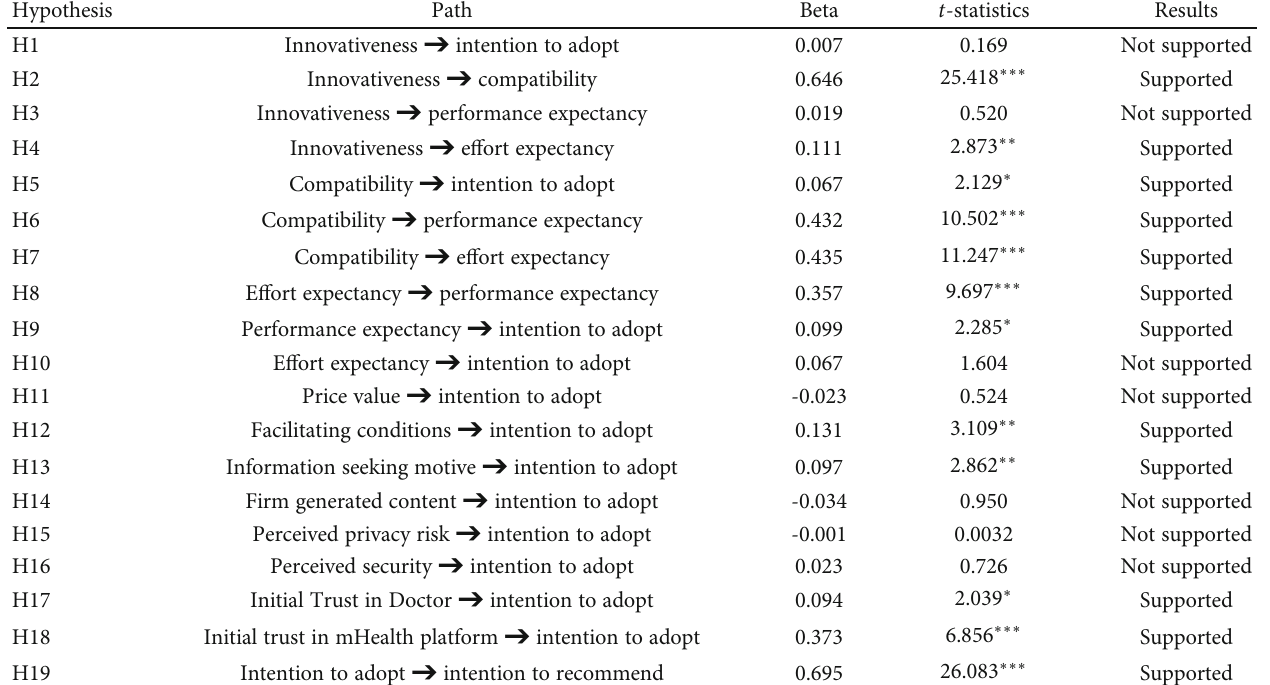
Table 6: Hypotheses results.